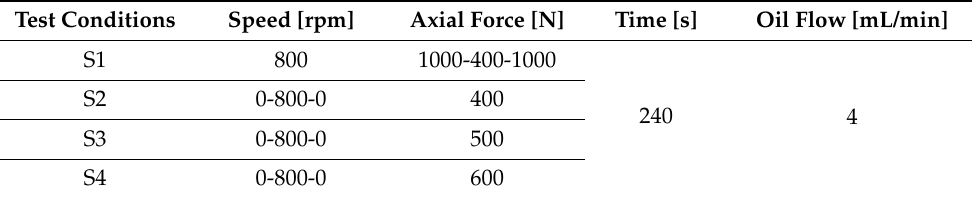
Table 5. Test conditions.